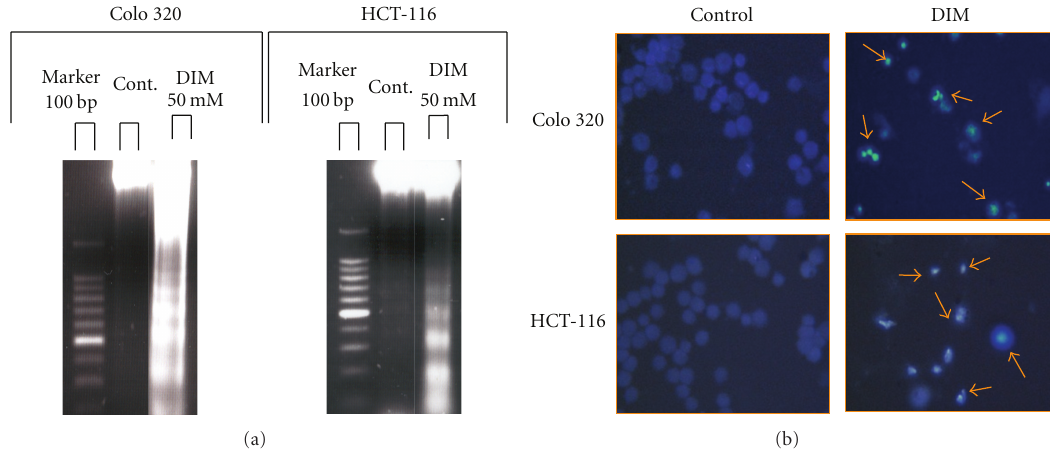
Figure 2: Apoptosis formation by DIM in Colo 320 and HGT116 cell lines. Cells were treated with DIM 60 μ M for 72 hours. DNA was extracted and separated on a 1.5% Agarose gel. The data shown were repeated three times (a). Morphologic changes, denoting apoptotic cells were shown by cell morphological changes. Cells were incubated in the presence of 60 μ M DIM for 48 hours and stained with DAPI. Morphologic changes are shown by arrows (b). The data shown were repeated three times.